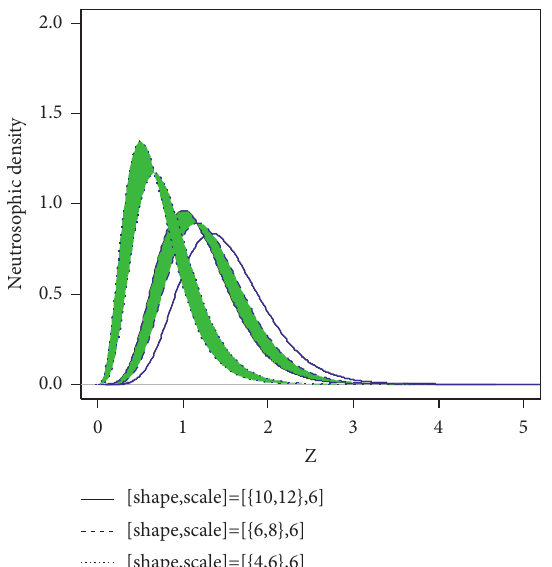
Figure 2: The density of the NGD with the neutrosophic shape